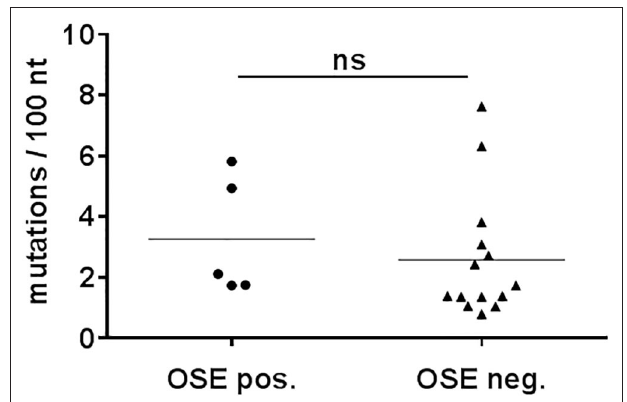
FIGURE 5 | Number of mutations in Vh-genes of monoclonal IgG. CASP surgery was performed on C57BL/6 mice. Hybridomas were generated by fusing splenocytes from 10- days-septic mice. The resultant monoclonal IgG hybridomas were sequenced for Vh-genes. Mutations of monoclonal IgG that showed binding to OSEs (OSE pos.) were compared to IgG that showed no binding (OSE neg.). Statistical analysis was performed using the unpaired t -test. N = 5–14 per group. nt, nucleotides; ns, not